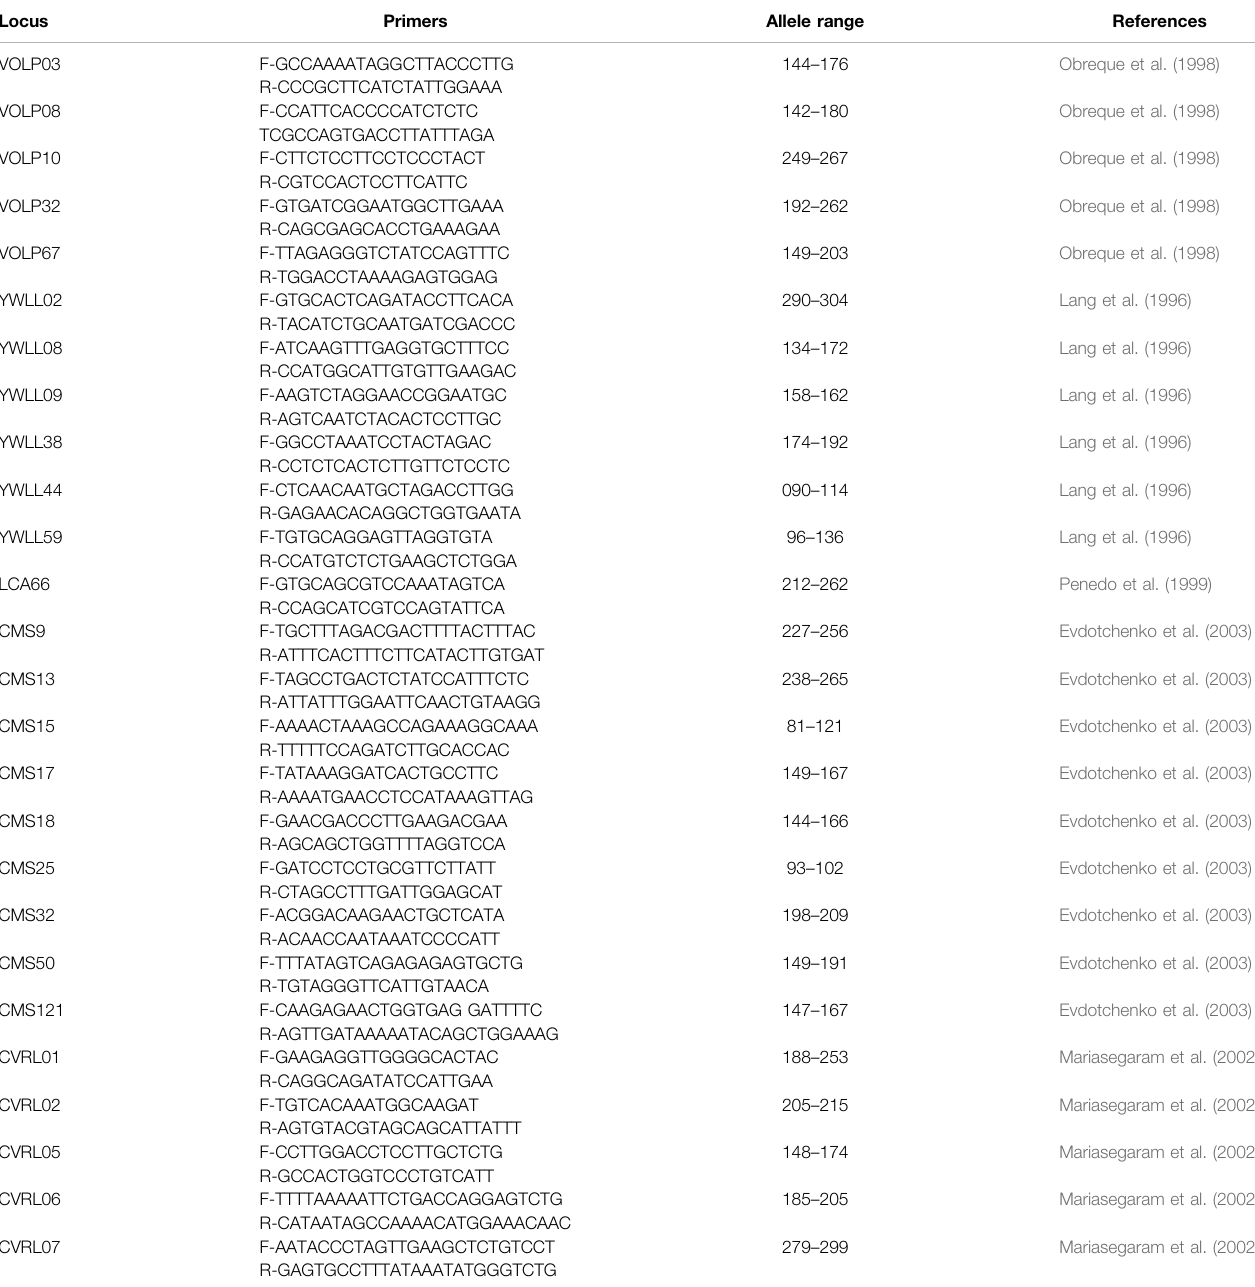
TABLE 1 | Primers, allele range and reference of the 25 microsatellites recommended for Dromedary camel by the International Panel on Animal Genetic